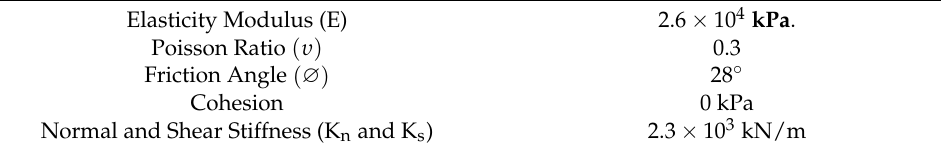
Table 2. Input parameters for geogrid.